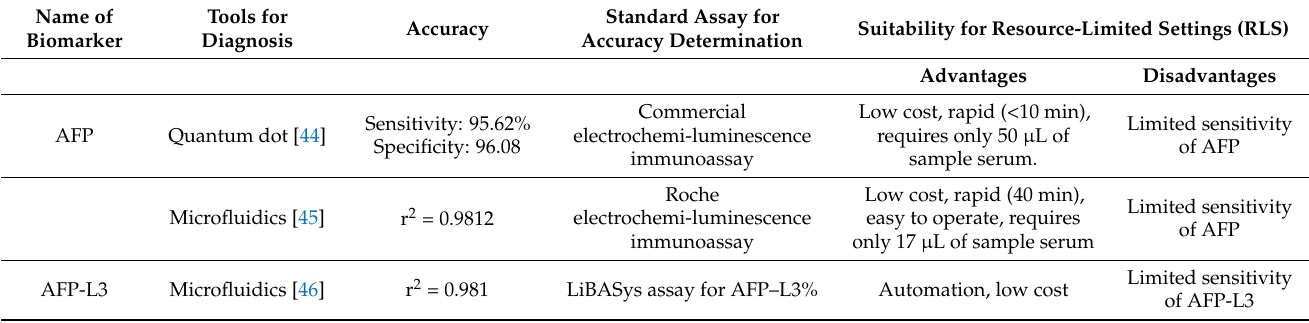
Table 2. Low-cost techniques for detecting HCC proteins in the